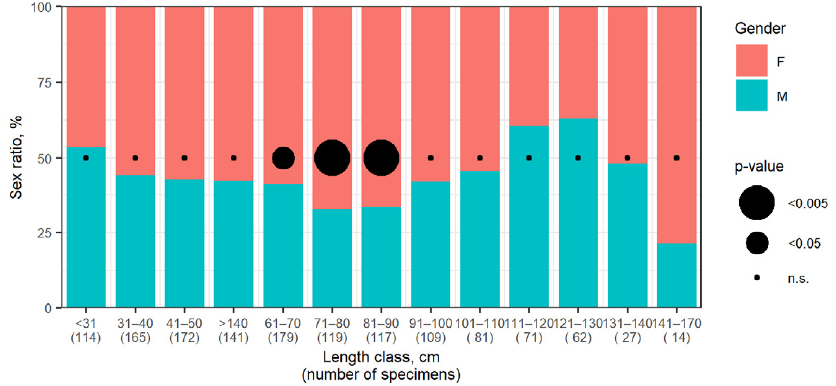
Figure 13. Sex ratios by size class of the Aleutian skate Bathyraja aleutica from the North Pacific. Black circles show the test of proportion (1:1) p -value.